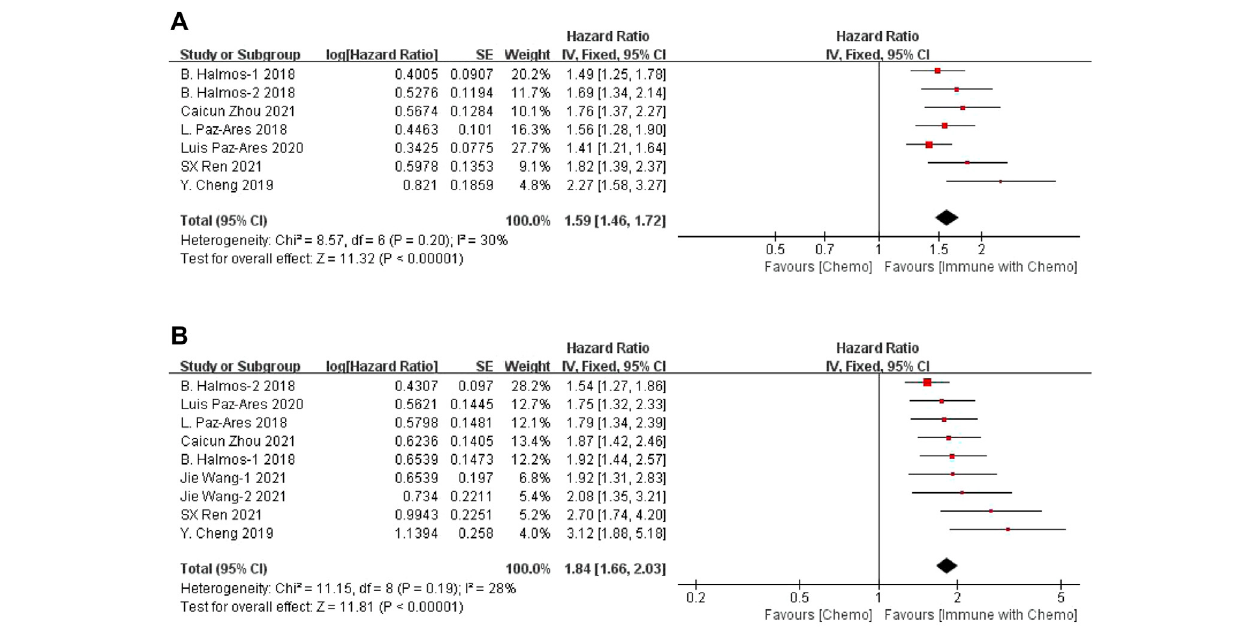
FIGURE 2 | Meta-analysis results of OS (A) and PFS (B) between the chemo with immune group and chemo group.